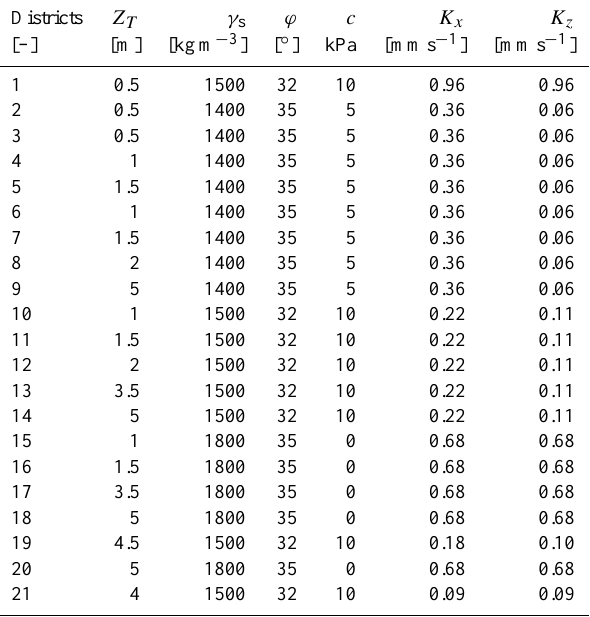
Table 3. Values of the static variables for the 21 homogeneous dis- tricts of Sambuco Basin.